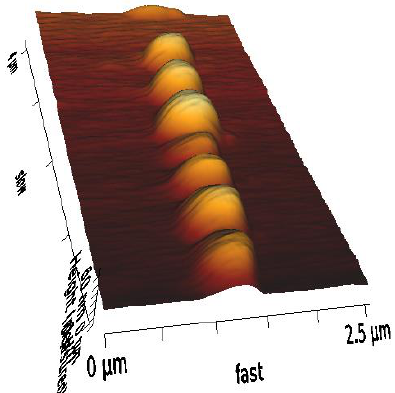
Fig. 5. AFM micrographs of magnetic DNTs whth extrier alignments of MNP in the surface of DNTs. The alignment of nanoparticles in a line indicates the occurrence of streptavidin- biotin binding between the streptoavidin coated nanoparticles and biotinylated oligo-aptamers.